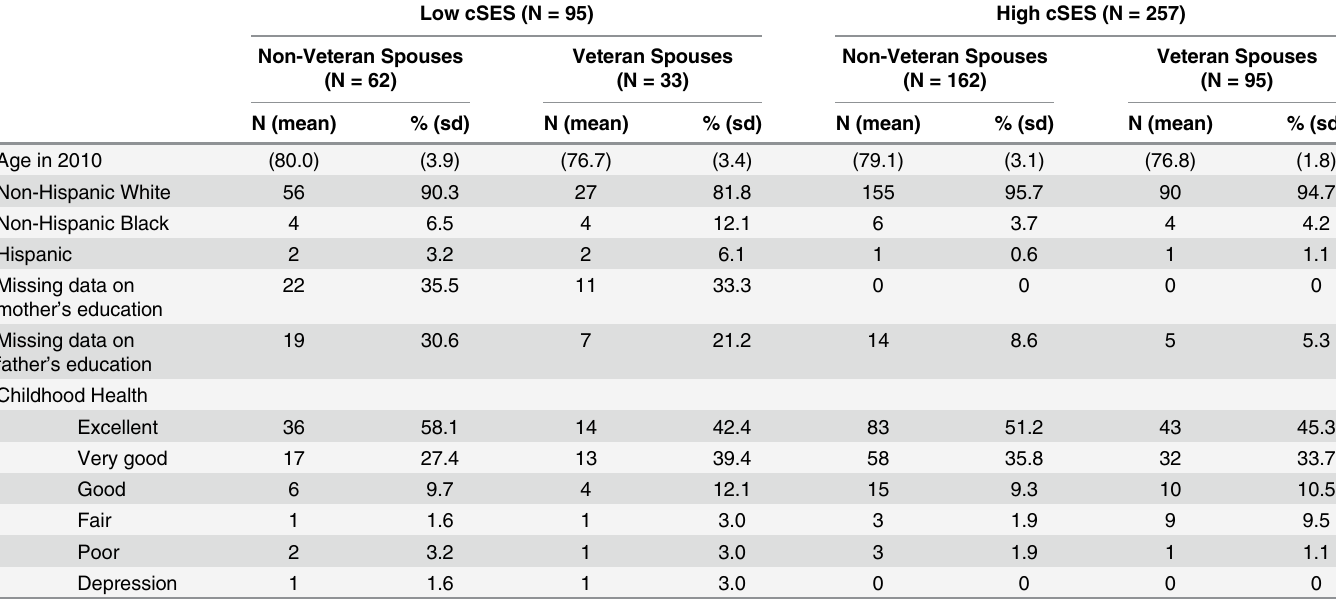
Table 1. Distribution of covariates in the CEM analytic